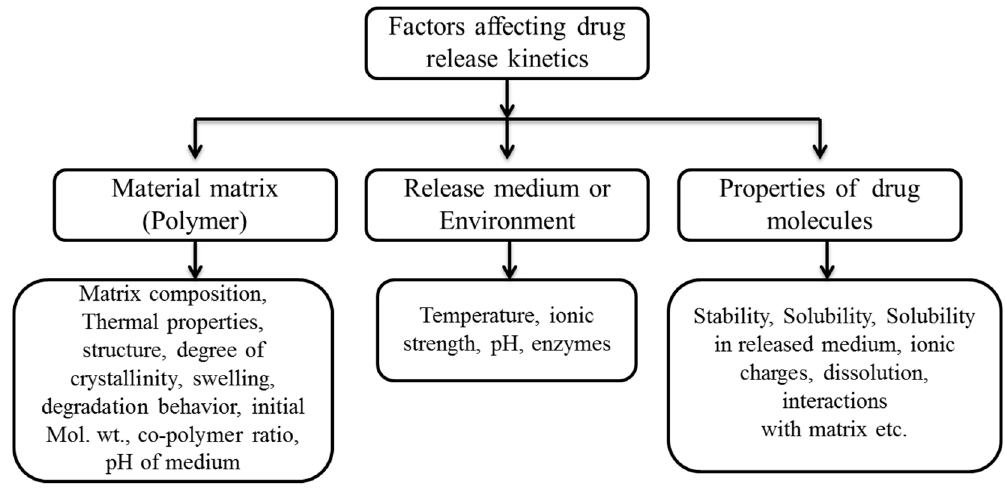
Figure 3. A summary of main factors influencing drug release kinetics.